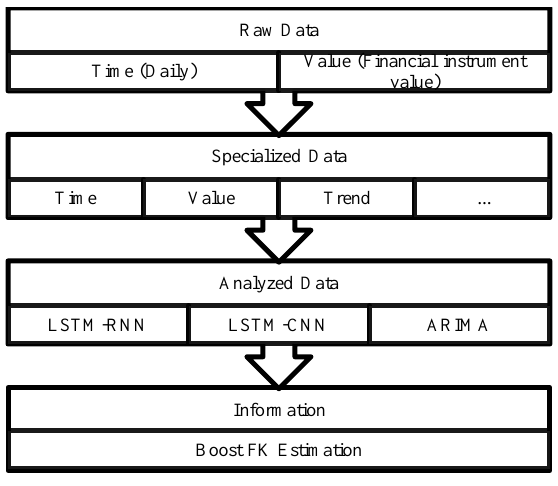
Figure 1. Data Life Cycle